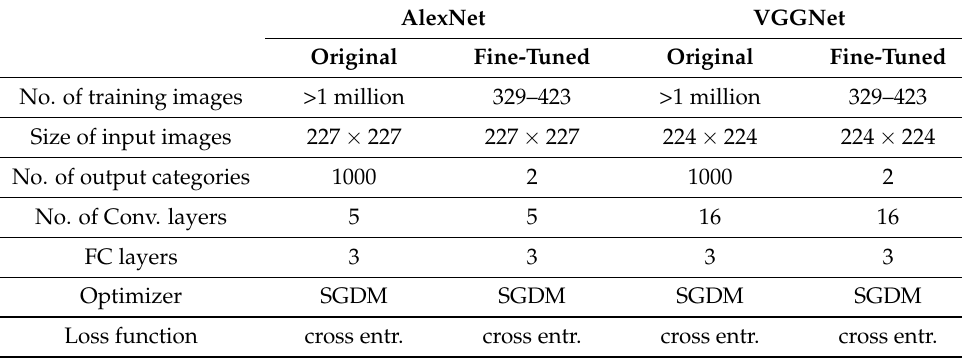
Table 1. Basic architecture and configuration parameters of both AlexNet and VGGNet, where Conv. means convolutional, FC means fully-connected, SGDM means stochastic gradient descent with momentum, and cross entr. means cross